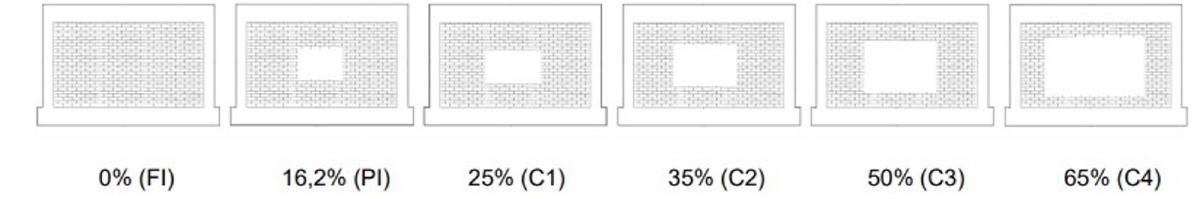
Figure 14. Models under study in Scenario C.